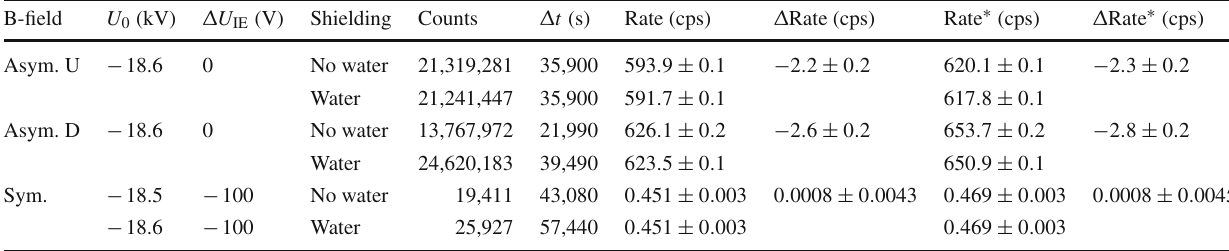
Fig. 4). Rate is the raw result from the detectedcounts and measurement duration Δ t , while Rate ∗ is corrected for the missing detector pixels. For the Asym. U (Asym. D) measurements, all rates exclude the inner 28 (4) pixels. The errors on the rates are statistical